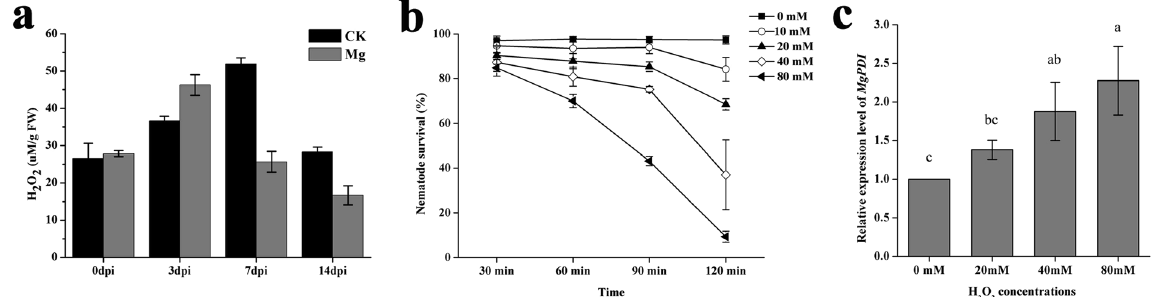
Figure 5. MgPDI expression is triggered by H 2 O 2 and increases H 2 O 2 tolerance. ( a ) The H 2 O 2 content per gram of fresh root tissue. ( b ) Mortality rate of freshly hatched J2s exposed to H 2 O 2 . ( c ) The relative mRNA expression levels of MgPDI in response to the H 2 O 2 stress. Vertical bars represent the means ± SD.